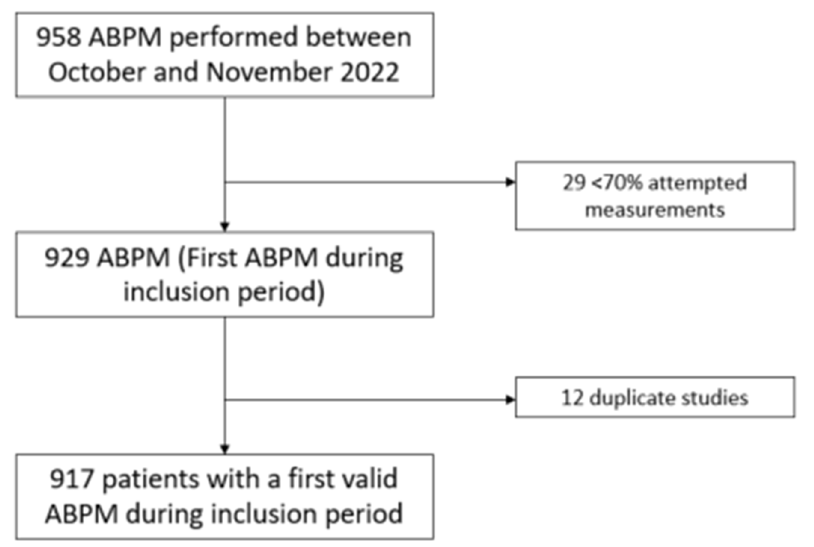
Figure 1. Study population flowchart. ABPM, ambulatory blood pressure monitoring.